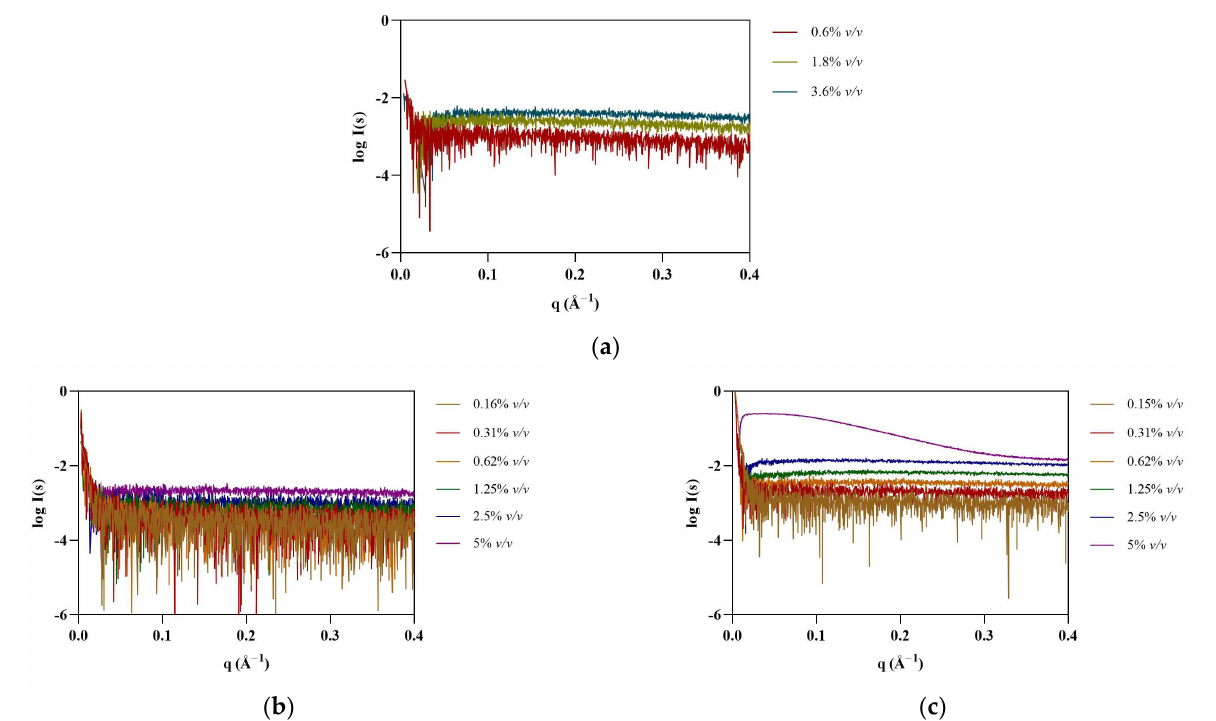
Figure 1. SAXS experimental scattering curves for IL blanks: ( a ) [N 1112(OH) ][H 2 PO 4 ], ( b ) [N 1112(OH) ][C 4 F 9 SO 3 ], and ( c ) [C 2 C 1 Im][C 4 F 9 SO 3 ].